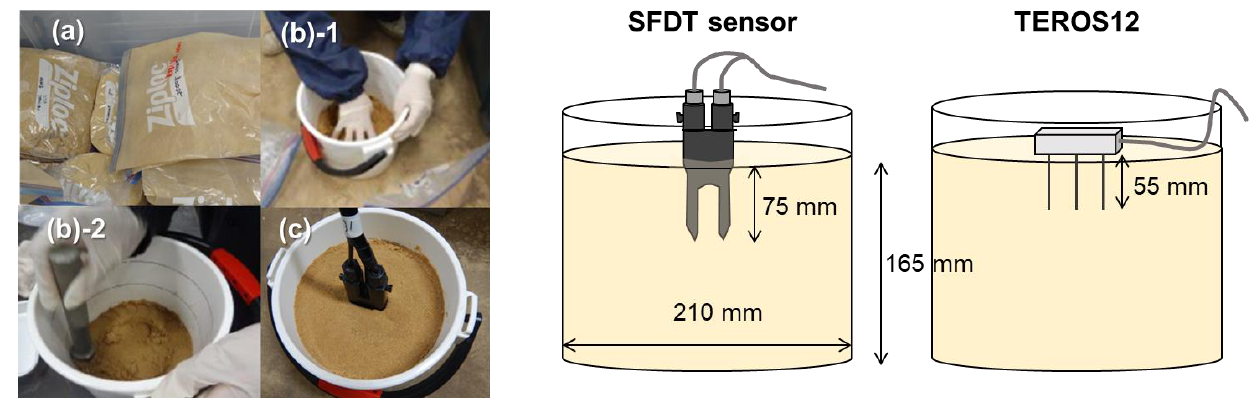
Figure 3. Pictures and schematic diagrams of the experiments: ( a ) moisture-adjusted samples in the plastic bags; ( b ) 1,2 uniform filling of the samples; ( c ) sensor insertion.